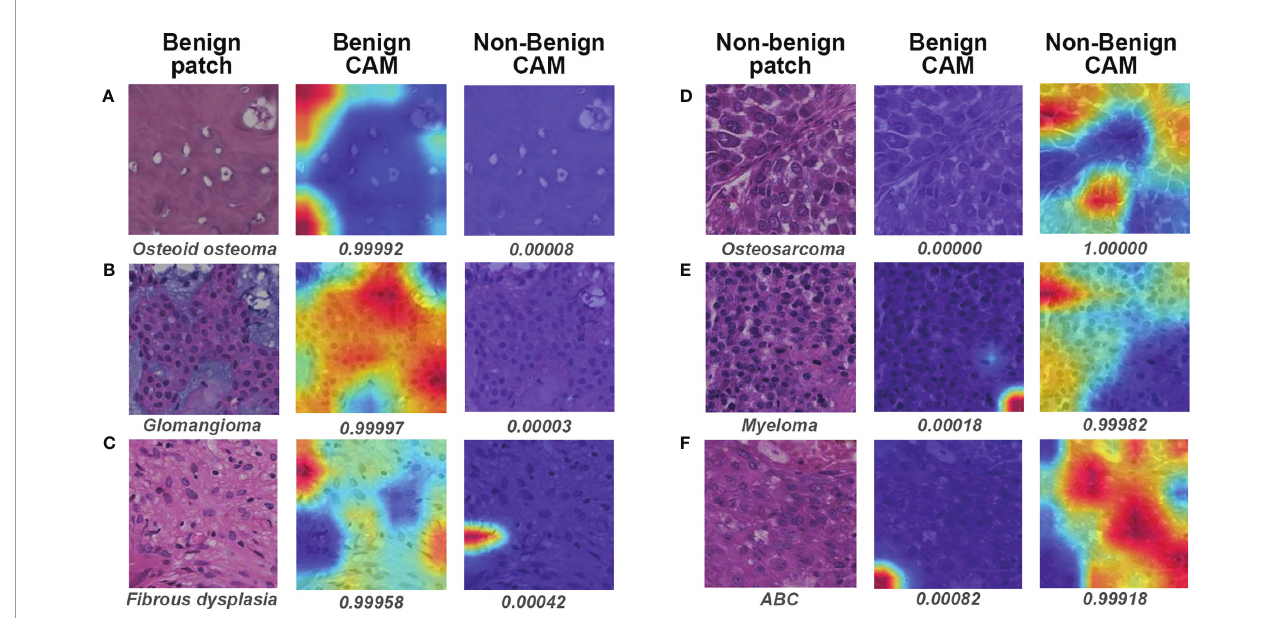
FIGURE 6 | Gradient-weighted class activation mapping (Grad-CAM) in binary classi fi cation for representative patches of slides correctly classi fi ed by both models and pathologist #1. The speci fi c classi fi cation is shown under the original patch, and the predictive probability for CAM of each class is shown below the corresponding Grad-CAM heatmap. (A – C) show the representative patches of benign bone tumors, whereas (D – F) show the representative patches of non-benign bone tumors. CAM, class activation mapping; ABC, aneurysmal bone